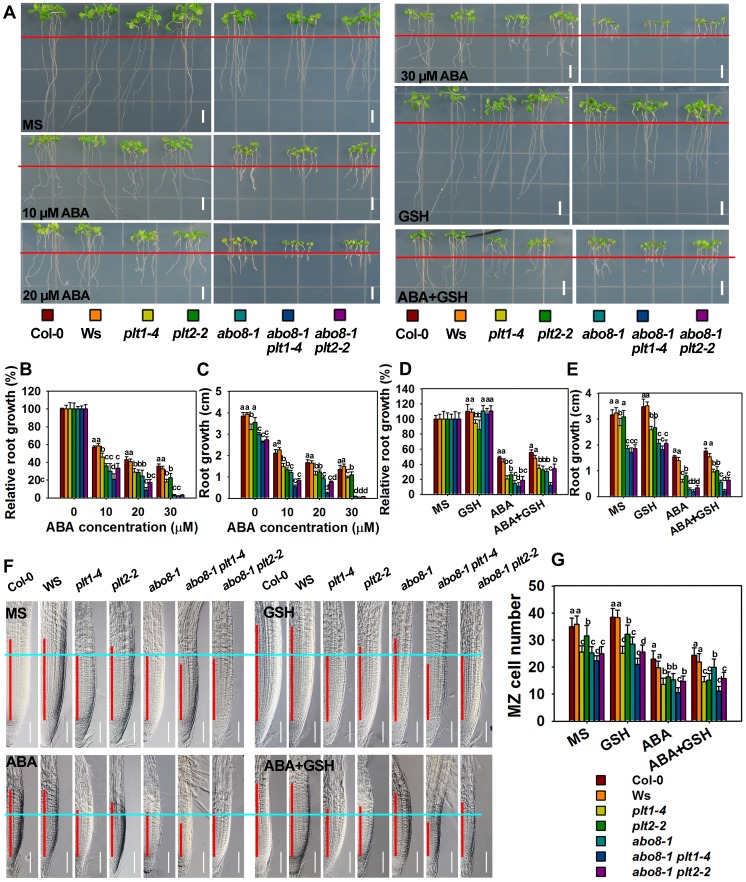
Genetic analysis of ABO8 with PLT1 and PLT2.A. The roots of the wild type Col-0, Ws, plt1-4, plt2-2, abo8-1, abo8-1 plt1-4, and abo8-1 plt2-2 grown on MS medium or MS medium supplemented with different concentrations of ABA, 300 µM GSH or 30 µM ABA plus 300 µM GSH for 5 days. Red line indicates the root tip positions after 5-day seedlings were just transferred onto different medium. Bars = 5 mm. B–E. The root growth and relative root growth of different plants in (A). Relative root growth is expressed to that of the wild type or mutants on MS without ABA. About 15 roots from three plates were measured in each experiment, and three experiments were done with similar results. Values are means ±SE, n = 3. Means with different letters are significantly different at P<0.01. F. The length of the root meristem (red line) of different genotypes on MS medium or MS medium supplemented with 30 µM ABA, 300 µM GSH or 30 µM ABA plus 300 µM GSH. Bars = 50 µm. G. The MZ cell number in (F). Three independent experiments were done with similar results, and each experiment had three replicates. About 20 roots were measured for each replicate. Values are means ±SE from one experiment. Means with different letters are significantly different at P<0.01.